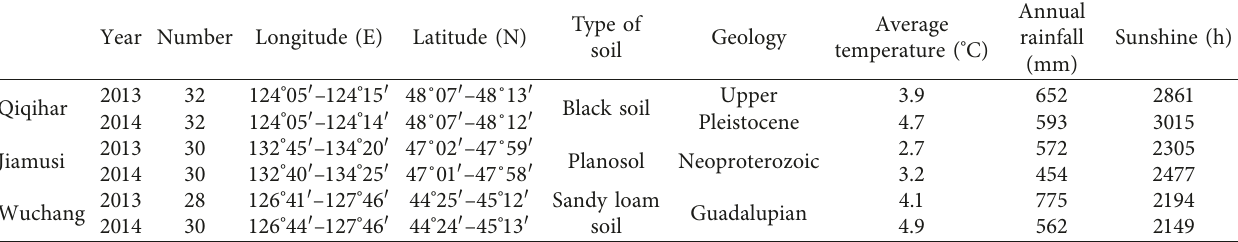
Table 1: The information of rice samples from three